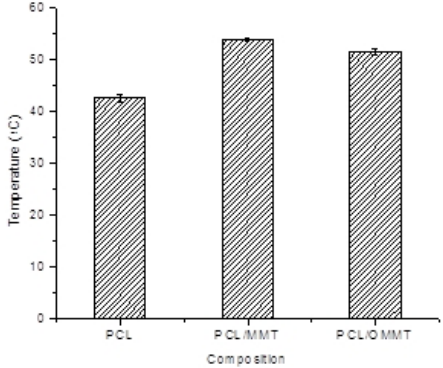
Figure 3. HDT measurements of PCL, PCL/MMT and PCL/ OMMT compounds.